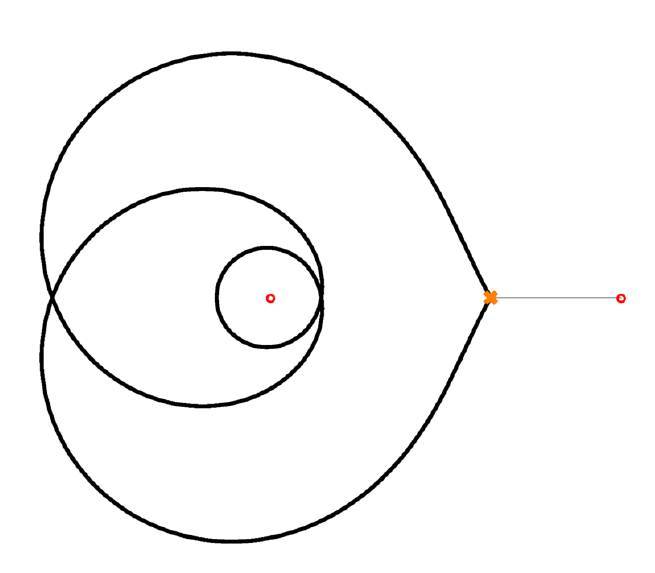
Figure 51. The D0 brane at framing where the mirror curve is cubic in y .